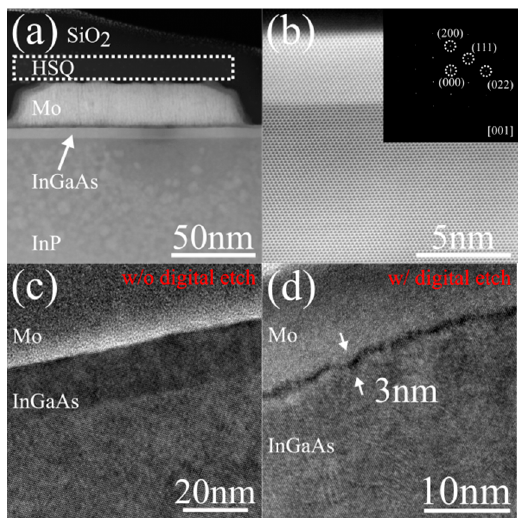
Figure 3. ( a ) STEM-HAADF (High-Annular Angle Dark Filed) cross-sectional image; ( b ) HR-STEM of the InGaAs layer (insert shows the Fast Fourier Transform FFT); TEM images of ( c ) the untreated sample and ( d ) the sample prepared with digital etch.